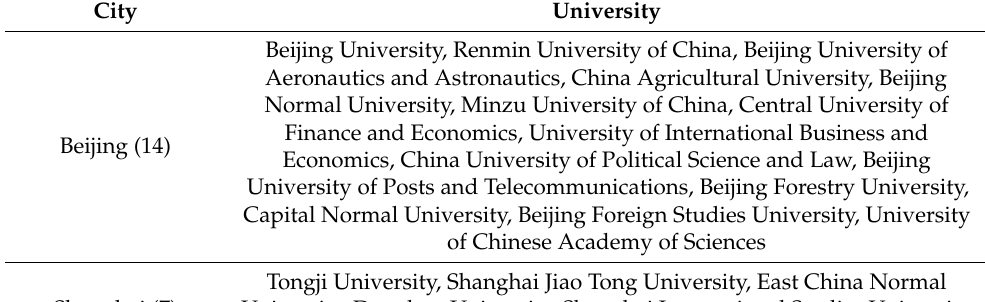
Table A1. List of 75 “Double First-Class”